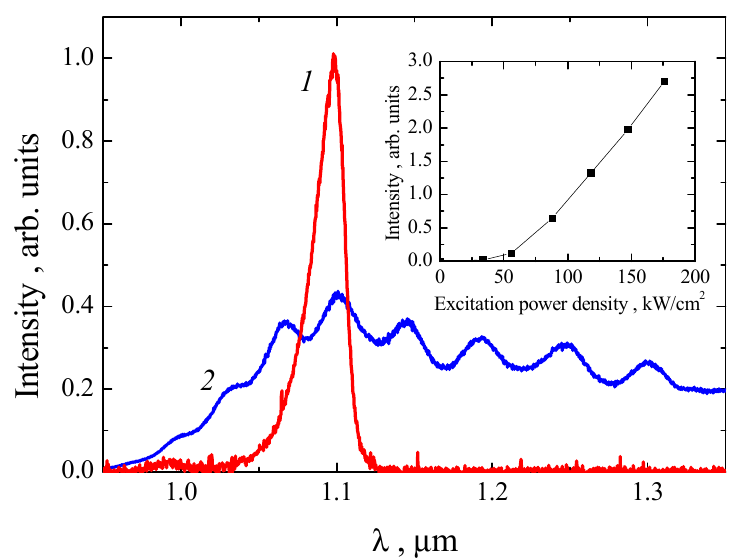
Figure 14. Spectrum of stimulated emission of the structure with the strained In 0.43 Ga 0.57 As/GaAs QW grown on a Ge/Si substrate ( 1 ). For comparison, the spectrum of spontaneous emission is shown (not to scale) ( 2 ). The pumping power densities are 100 kW/cm 2 and 5 W/cm 2 for ( 1 ) and ( 2 ), respectively. The measurement temperature is T = 77 K. Dependence of the integral emission intensity on the excitation power density is shown in the inset.